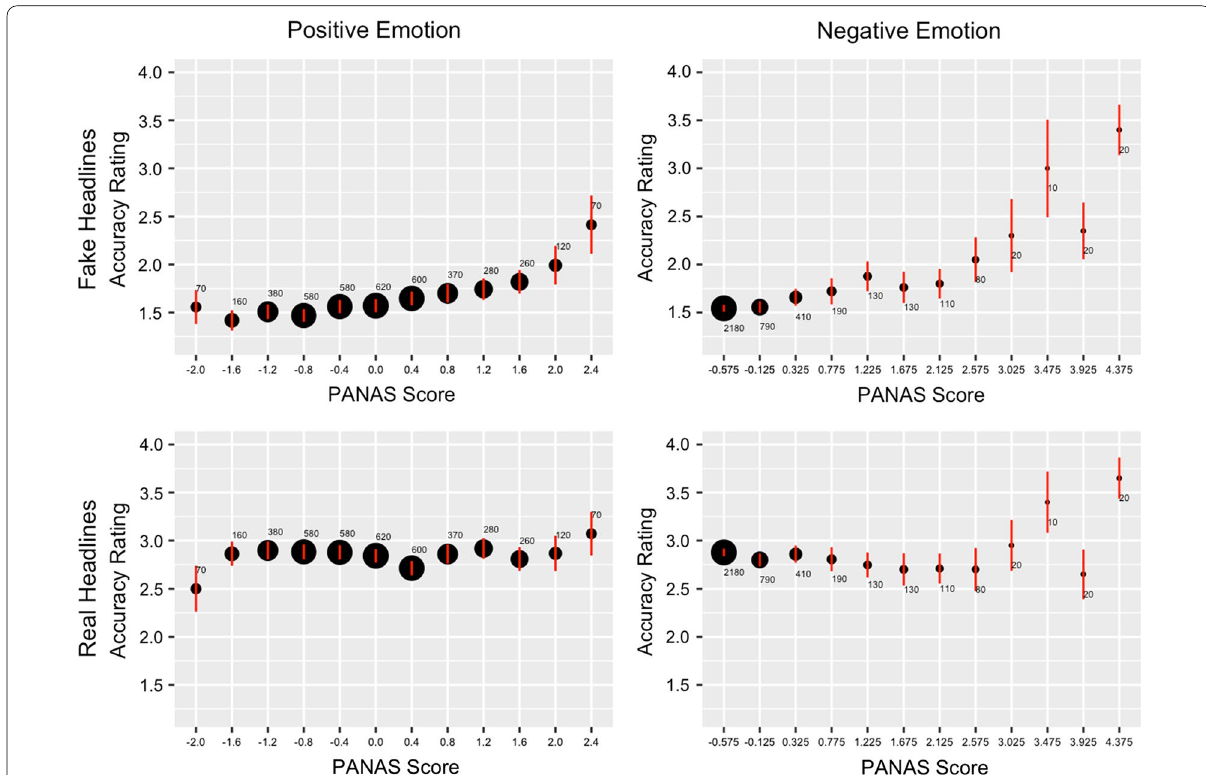
Fig. 2 Plotting reported news headline accuracy as a function of aggregated positive or negative PANAS score shows a positive relationship between both positive and negative emotion and belief in fake news. This relationship is not as evident for belief in real news. Dot size is proportional to the number of observations (i.e., a specific participant viewing a specific headline). Error bars, mean